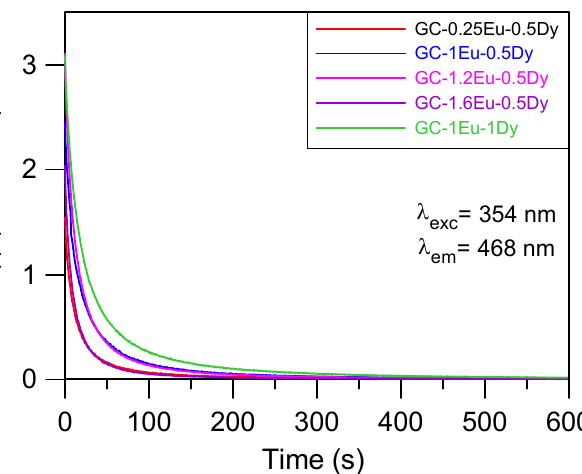
Figure 9. Persistent luminescent decays at 468 nm from Eu 2+ , excited for 10 min at 354 nm for the co ‐ doped samples. Table 9. Lifetimes of the persistent luminescence kinetics excited at 354 nm for the co ‐ doped sam ‐ ples.